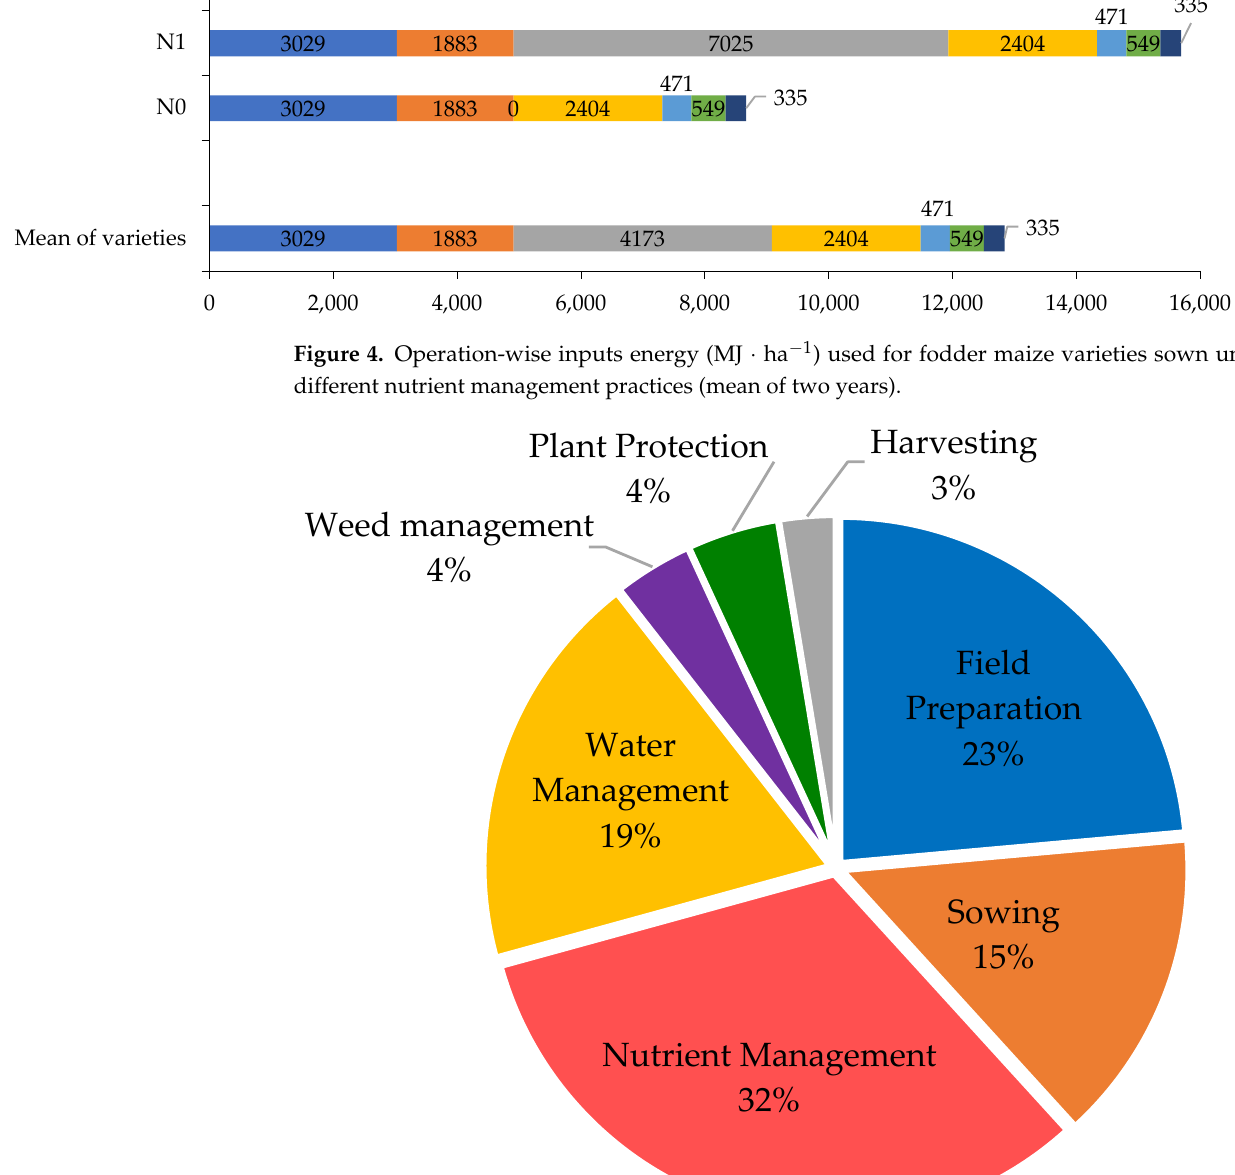
Figure 5. Operation-wise mean share of inputs energy used for fodder maize (mean of two years).